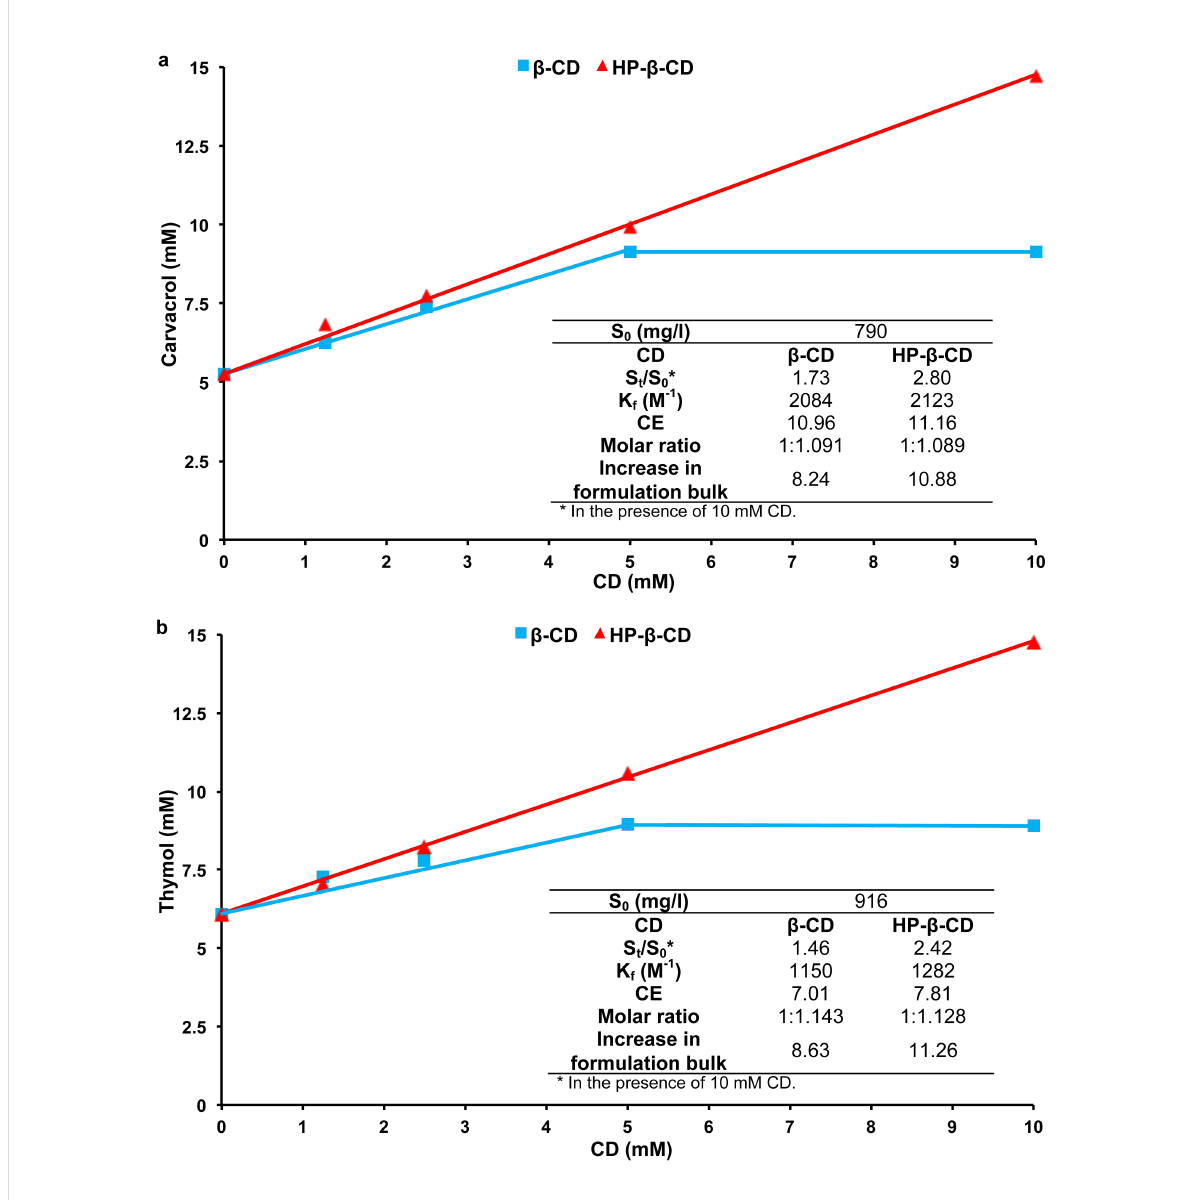
Figure 2: Phase solubility profiles of (a) CD/carvacrol ( 1 ) and (b) CD/thymol ( 2 ) inclusion complexes. Inset: Values of formation constants ( K f ), solu- bility enhancement ratio ( S t / S 0 ), complexation efficiency (CE), optimum molar ratio and increase in formulation bulk of each guest.